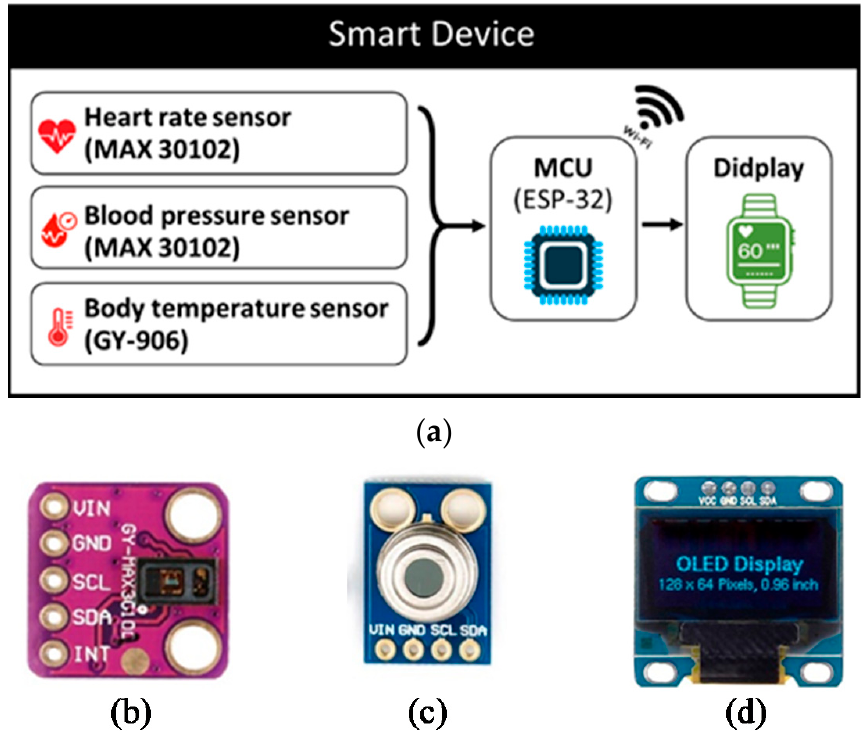
Figure 6. A process flowchart of the device ( a ) tools used in smart device designs; ( b ) MAX-30102; ( c ) GY-906; ( d ) OLED display screen.